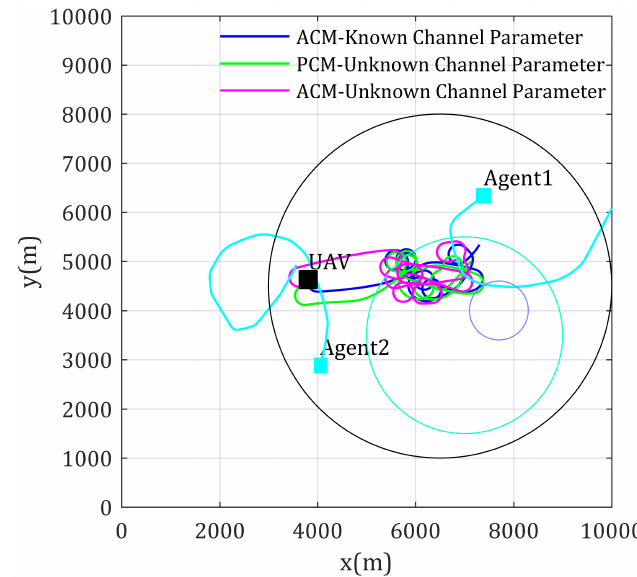
Figure 14. Paths for two mobile agents end-to-end communication with unknown channel parameters.